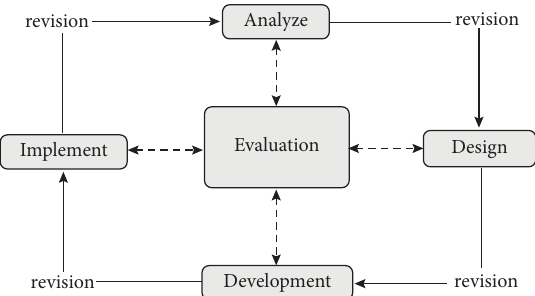
Figure 2: ADDIE’s instructional design model.